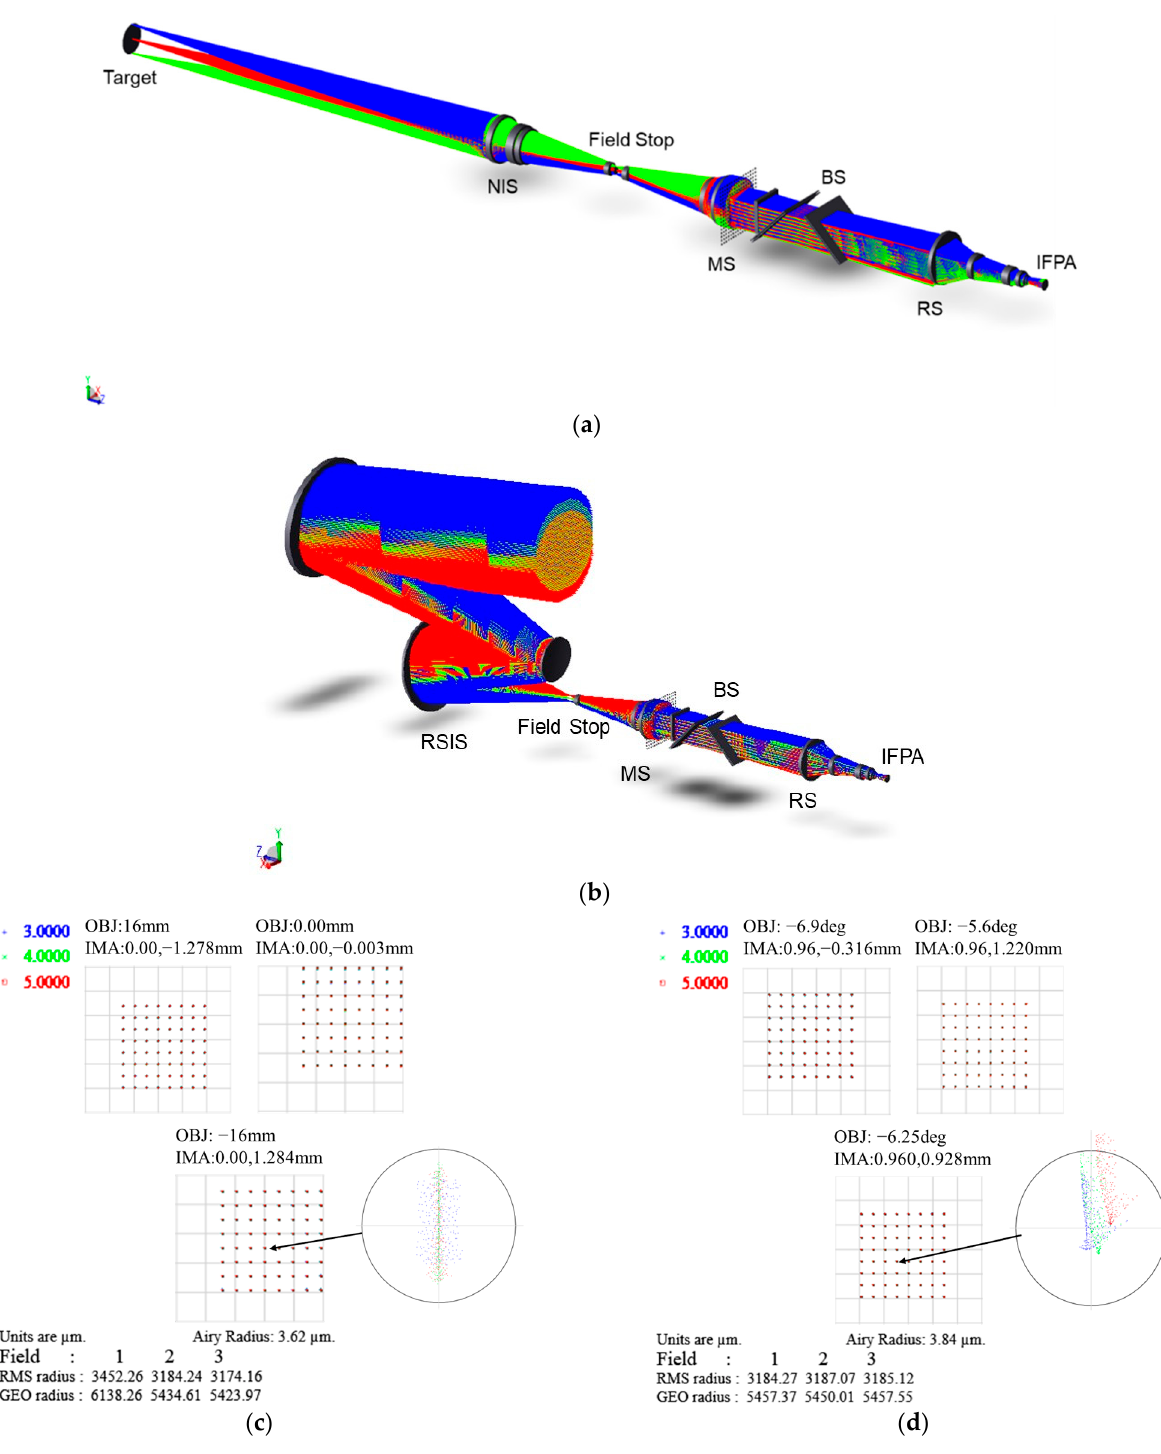
Figure 12. SIIFTS geometric simulation results: ( a ) SIIFTS layout applied for near ‐ field target detec ‐ tion; ( b ) SIIFTS layout applied for remote sensing; ( c ) full field spot diagram of the geometric simu ‐ lation determined by near ‐ field target detection; ( d ) full field spot diagram of geometric simulation carried out during remote sensing.